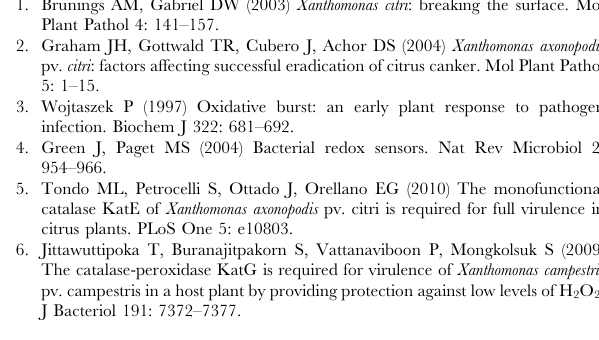
Figure S1 Determination of the dissociation constants for the FNR-NADP + complexes. The absorbance changes elicited by NADP + on each enzyme in the 490–510 nm region were used to calculate the K d values by fitting the data to a theoretical equation for a 1:1 complex. Xac -FNR ( # ), pea-FNR N ( & ), Ec -FNR ( ). (TIF) Figure S2 Determination of the kinetic parameters of the diaphorase reaction for the different enzymes. Kinetics of the ferricyanide reduction by Xac -FNR ( # ), pea- N FNR ( & ) and Ec -FNR ( ) using NADPH (A) and NADH (B) as substrates. (TIF) Figure S3 Kinetics of cytochrome c reductase reactions of the different FNR enzymes. Reduction of cytochrome c by N pea-FNR ( & ) and Ec -FNR ( ) using pea ferredoxin (A), E. coli ferredoxin (B) and E. coli flavodoxin (C) as substrates. (TIF) Figure S4 Alignment of the complete sequences of subclass I bacterial FNRs. Sequences of FNRs from